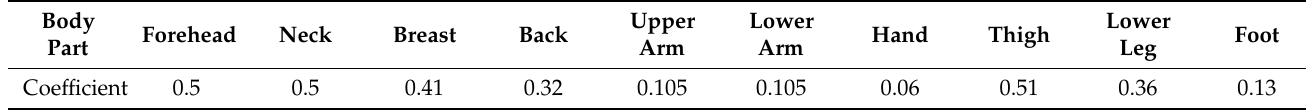
Table 2. Calculated weights of each part